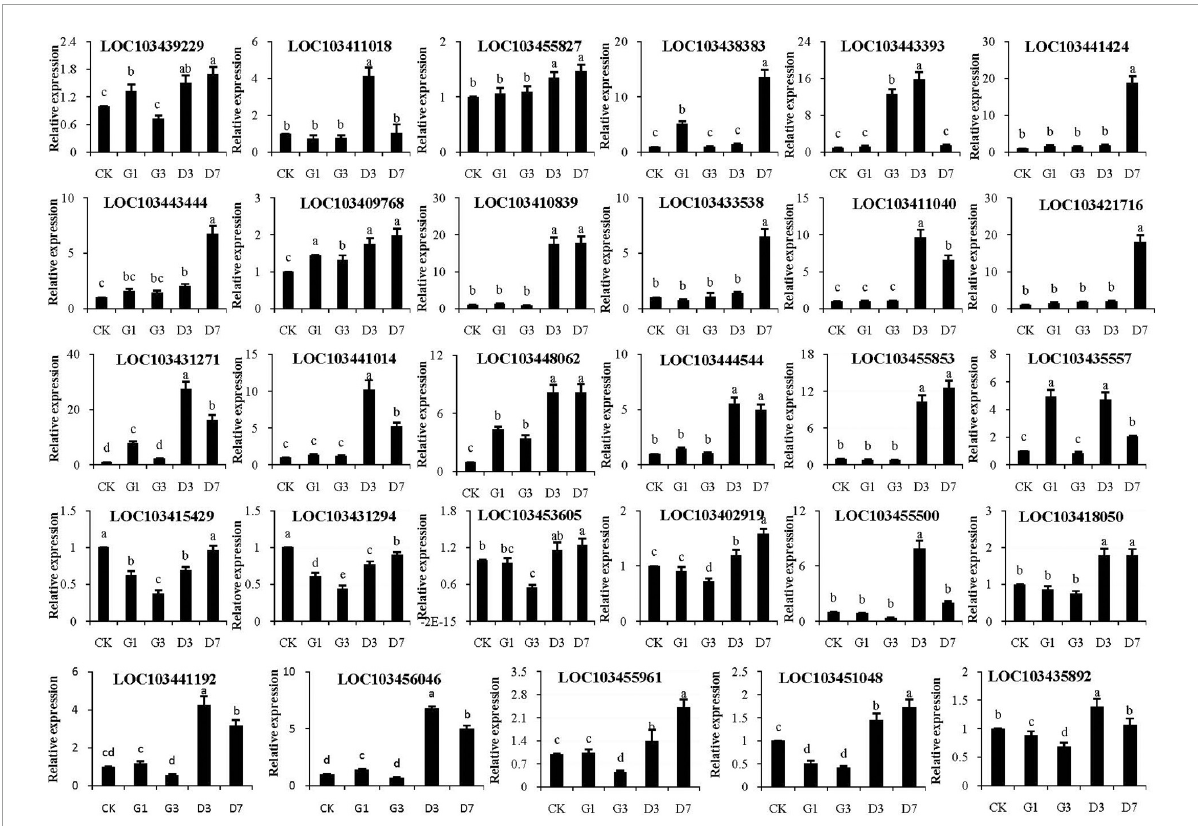
FIGURE9 Verification of the expression of MdUFGT and transcription factor ( MdMYB , MdNAC , and MdbHLH ) genes in the peel in different treatments by